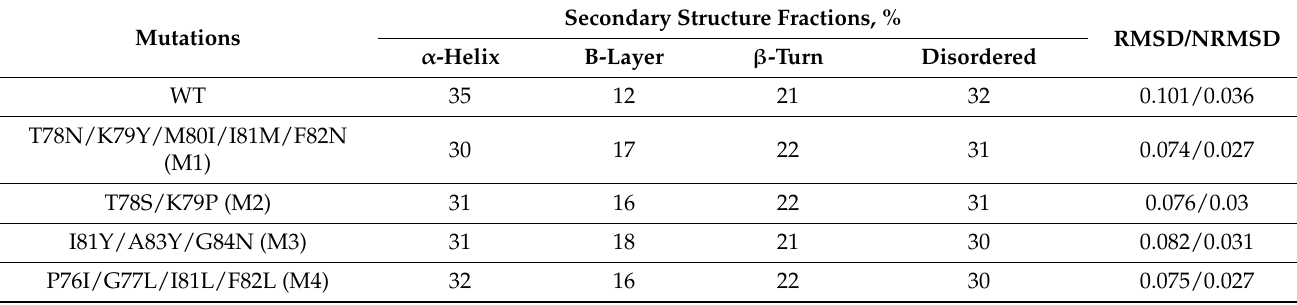
Table 1. The secondary structure analysis of cytochrome c (WT) and its mutant variants. The proportion of α -helix, β -layer, and β -turn in the molecule’s structure are given. RMSD and NMRSD represent root-mean-square deviation and normalized-mean-square deviation between the calculated and the experimental CD spectra, respectively. Secondary Structure Fractions, % Mutations RMSD/NRMSD α -Helix